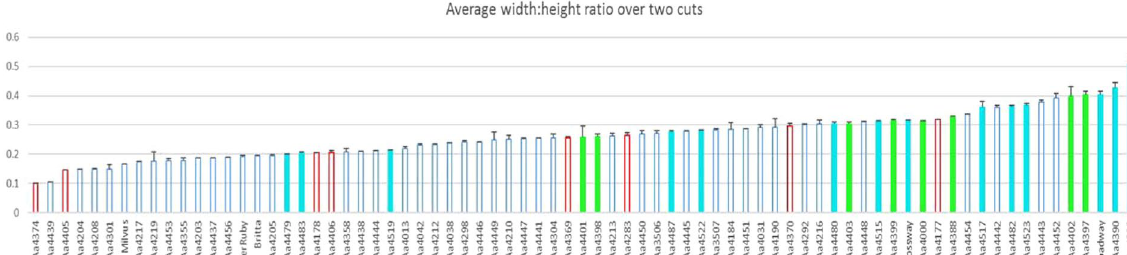
Figure 5. Average plant width to height ratio, with error of the ratio, of phenotypic data collected in year two, and averaged over two cuts. Measurements are in cm, and the graph is coloured in the same way as in the cluster and PC analyses. The varieties are labelled AberRuby, Britta, Grasslands Broadway, Crossway, and Milvus. Average plant heights ranged from 10–153 cm. Average plant widths ranged from 10–44